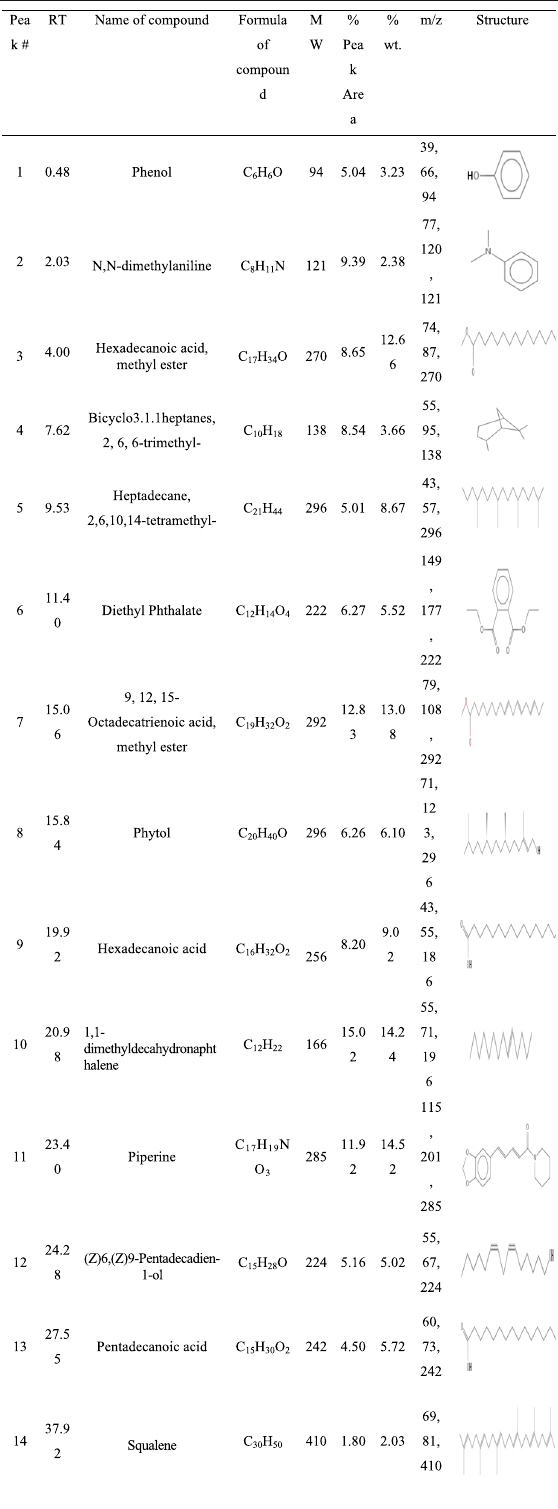
Table 6 GC-MS analysis of volatile organic compounds present in the root bark extract of Petiveria